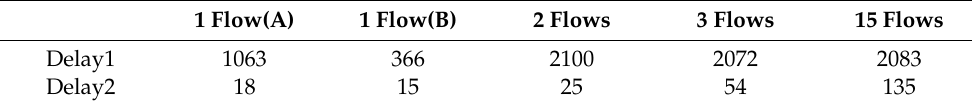
Table 5. Stress functional tests comparison (delay values in ms, obtained from